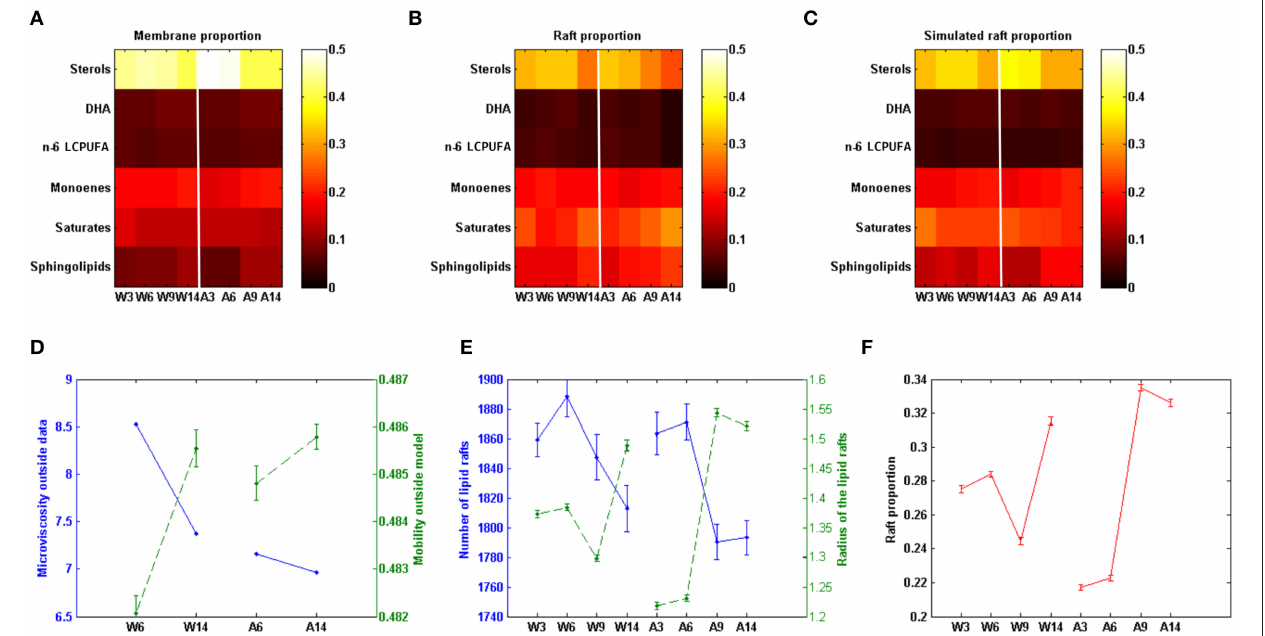
FIGURE 2 | Comparison of experimental and model predicted membrane features. (A) Lipid groups composition in cell membrane in different conditions (data on Table S1). (B) Lipid groups composition in lipid rafts in different conditions (data on Table S2). (C) Model predicted lipid rafts composition (data on Table S3). (D) Comparison between model based values of mobility (dashed line) and experimental values of microviscosity (continuous line) in the membrane domain (data on Table S4). (E) Model predicted number (continuous line) and size (dashed line, as measured by the mean radius) of lipid rafts (data on Table S5). (F) Model prediction rafts proportion in membrane. W3; W6; W9; W14: Wild-type mice at 3, 6, 9, and 14 months of age. A3; A6; A9; A14: APP/PS1 transgenic mice of 3, 6, 9, and 14 months of age, respectively. Vertical red lines separate Wild-type and AD induced conditions (data on Table S6). All the experimental data in this figure were taken from Fabelo et al. (2012)